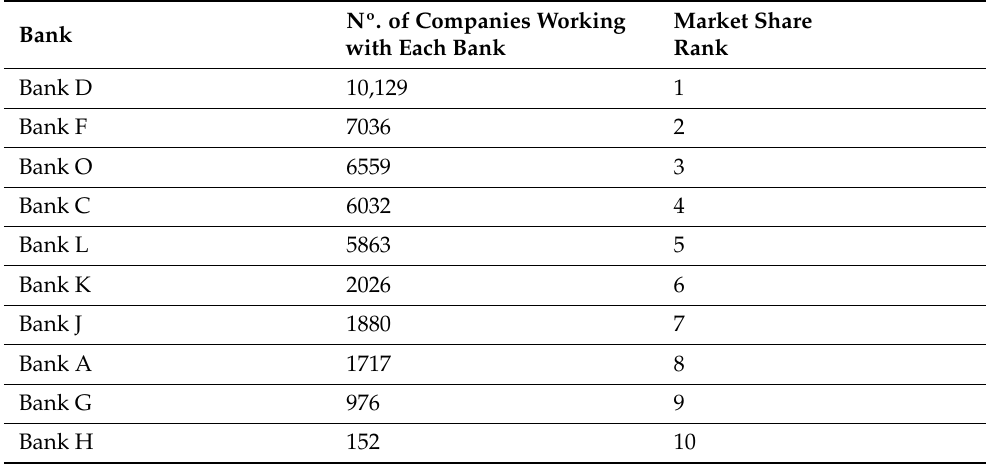
Table 1. Bank market share score per